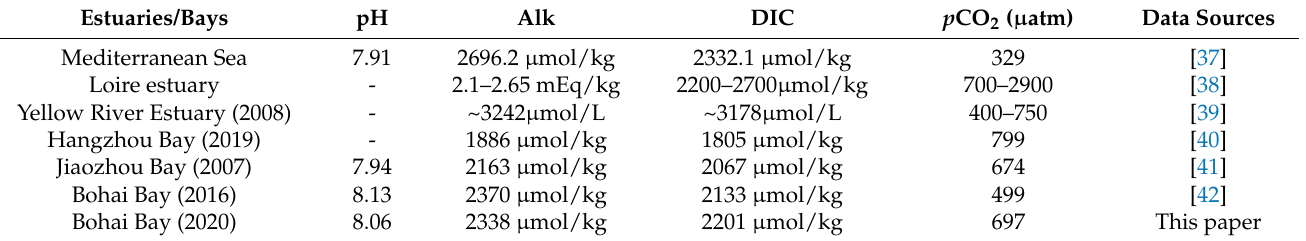
Table 4. Comparison of carbonate species in six different estuaries/bays in the Northern